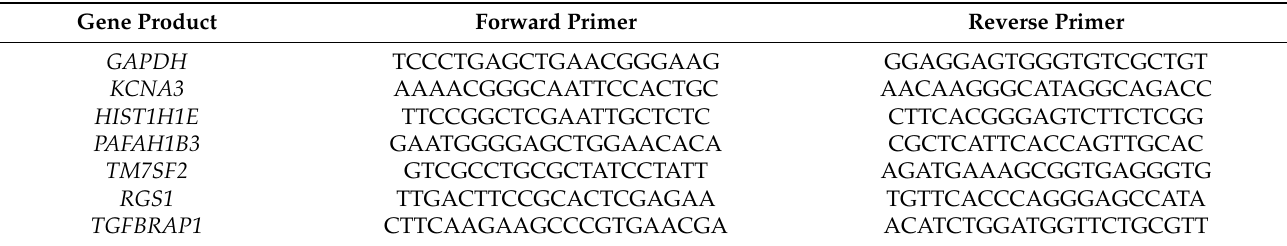
Table 1. Primers used in real-time QRT-PCR analysis.